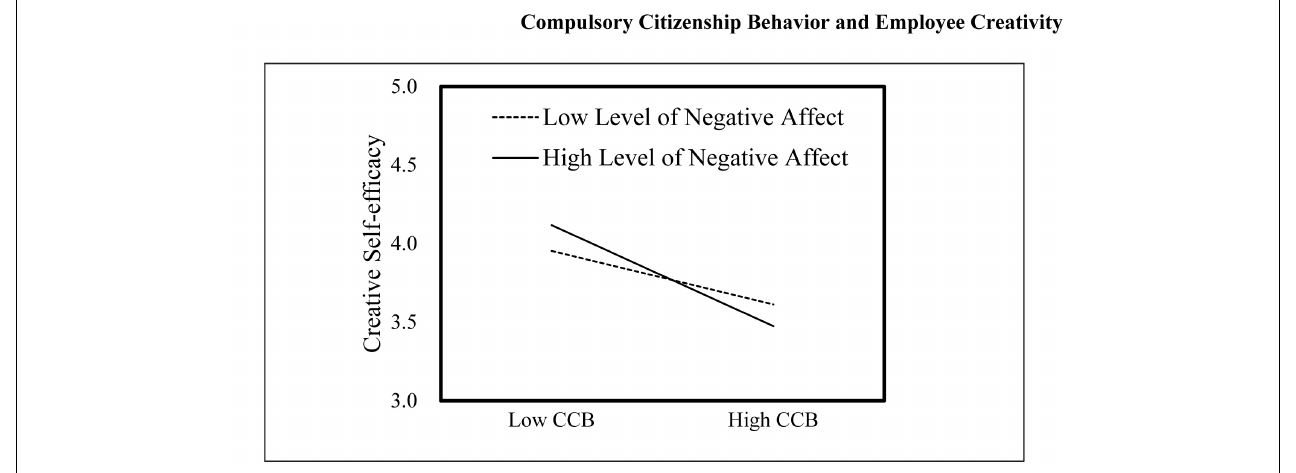
FIGURE 2 | Plot of interaction between CCB and negative affect on CSE. CCB, compulsory citizenship behavior; CSE, creative self-efficacy. TABLE 5 | Results for conditional indirect effect of CCB on employee creativity via CSE across levels of negative affect ( N = 251).